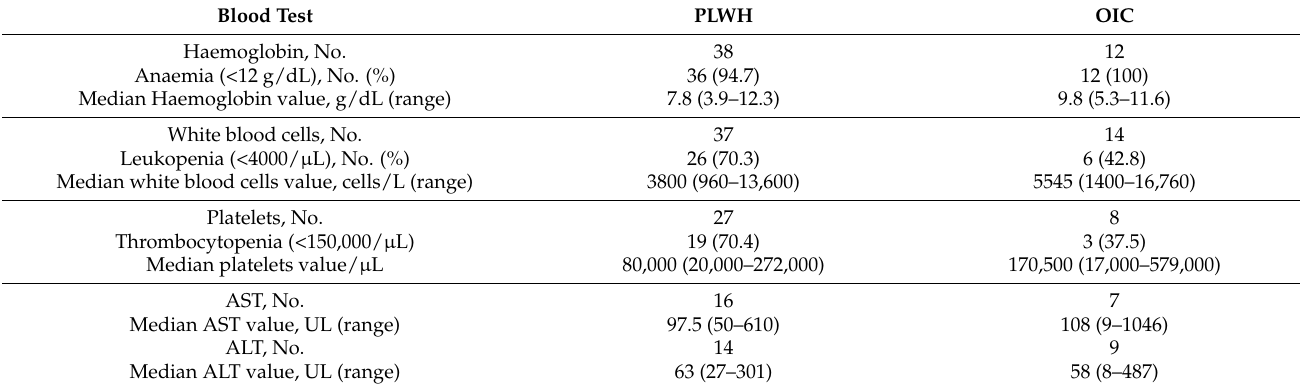
Table 5. The number of patients living with HIV (PLWH) or other immunocompromising conditions (OIC) undergoing the main blood tests. Blood Test PLWH OIC Haemoglobin,